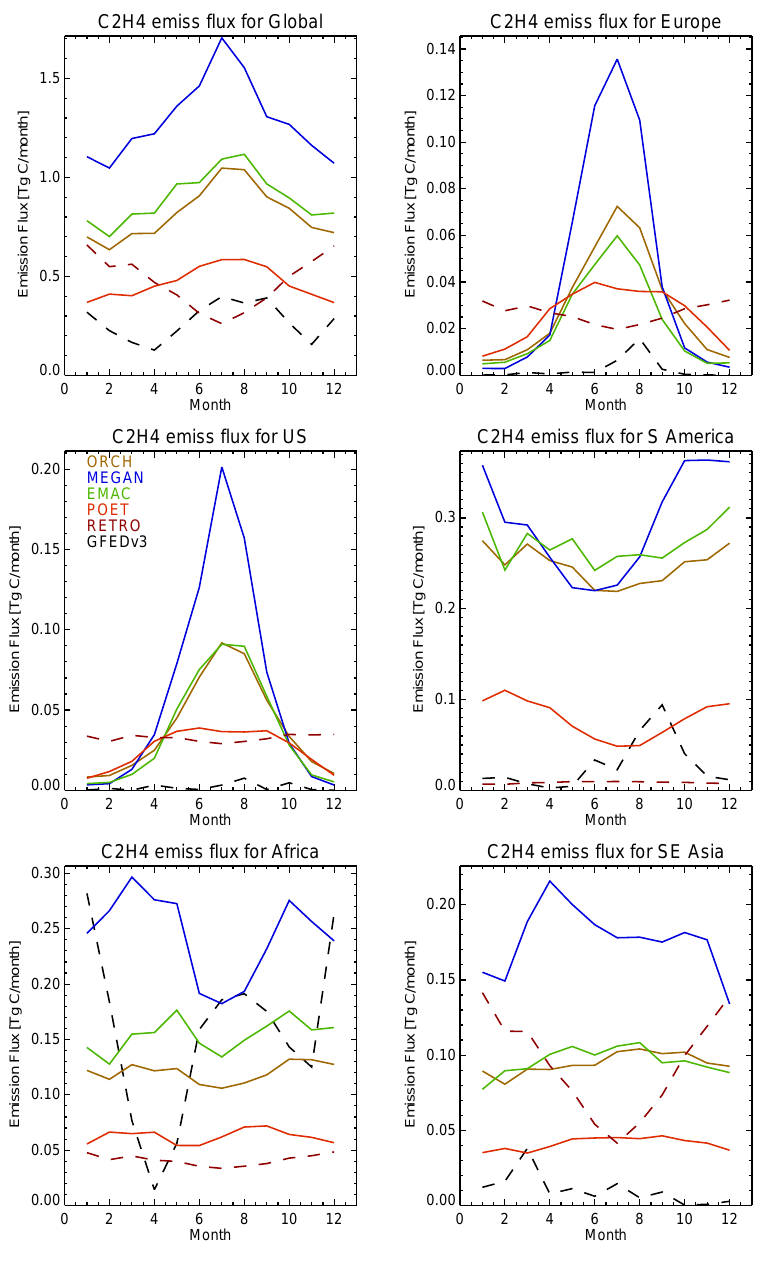
Fig. 2b. As for Fig. 2a except for C 2 H 4 .